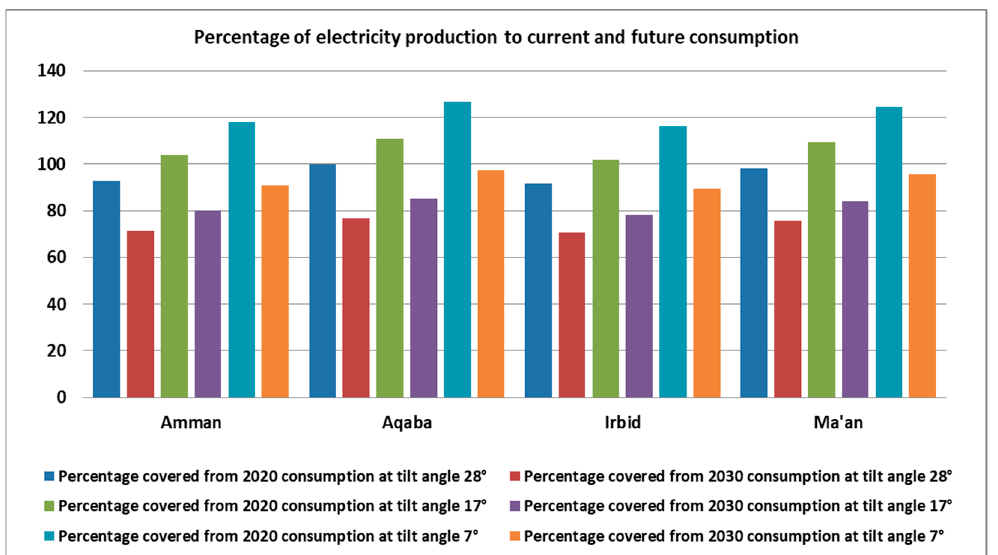
Figure 13. A comparison between electricity production from installing PV systems on the rooftops of apartment buildings type A2 in relation to its current and future energy consumption.